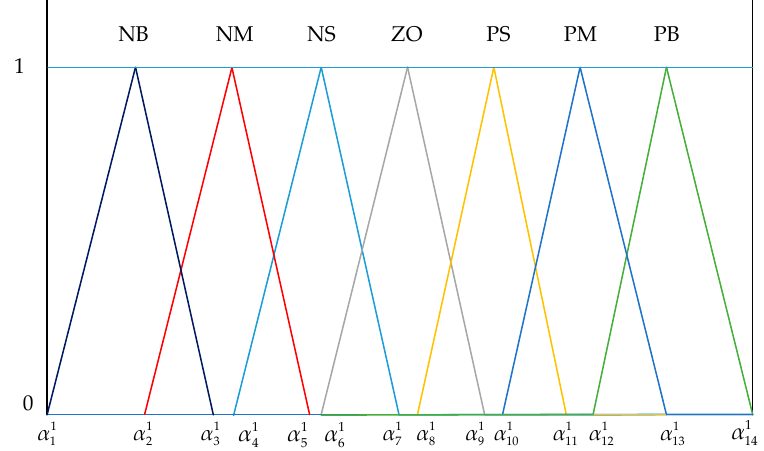
Figure 4. Membership function of the cross-track position error.